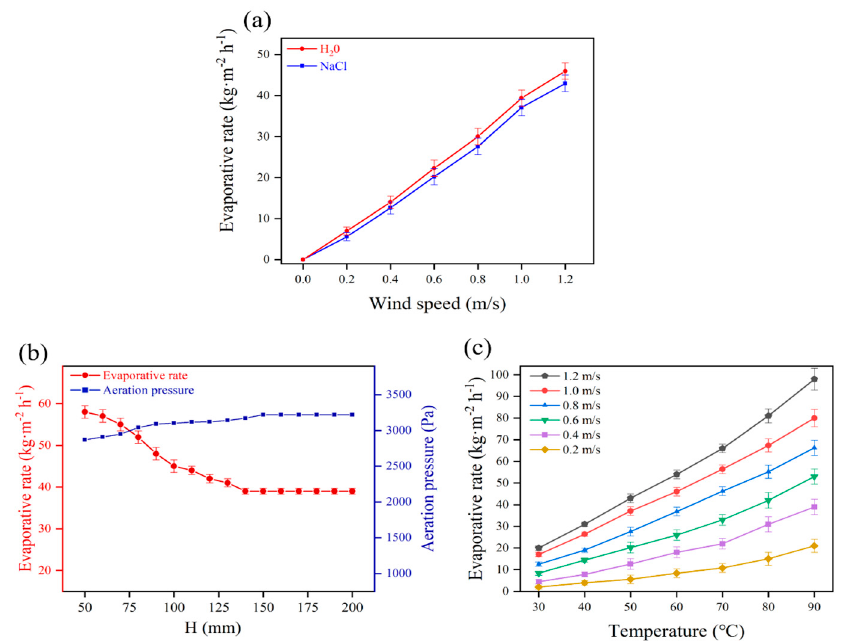
Figure 6. Impact of di ff erent conditions on evaporative rate: ( a ) wind speed; ( b ) height of the liquid column; and ( c ) air temperature.